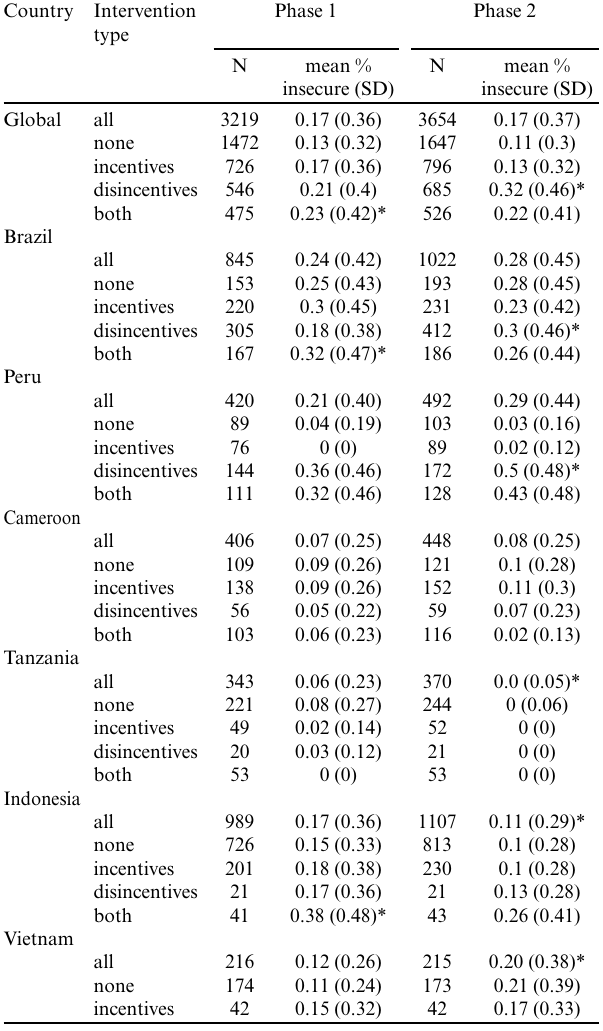
Table 3 . Average percent of household total landholding (ha) considered insecure by the household in both phase 1 and phase